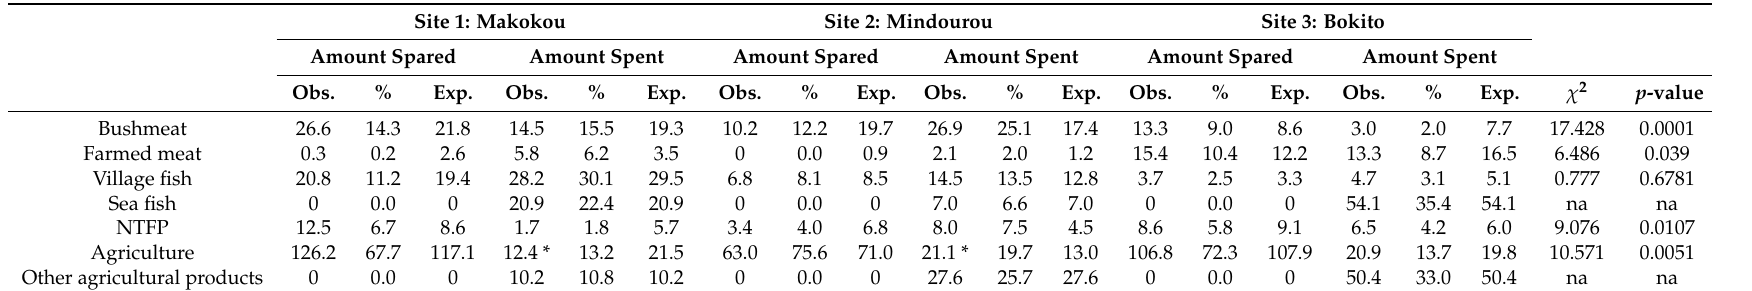
Table 4. Budget allocated for food in the three study sites in